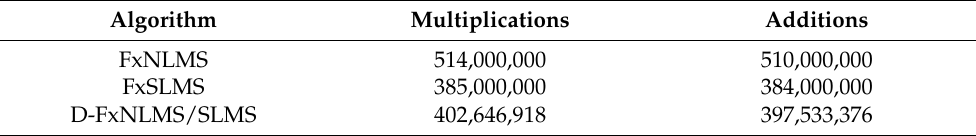
Figure 3. Performance comparison between FxNLMS, FxSLMS and the proposed D-FxNLMS/SLMS algorithm. Table 2. Number of multiplications and additions required to perform the FxNLMS, FxSLMS and the proposed